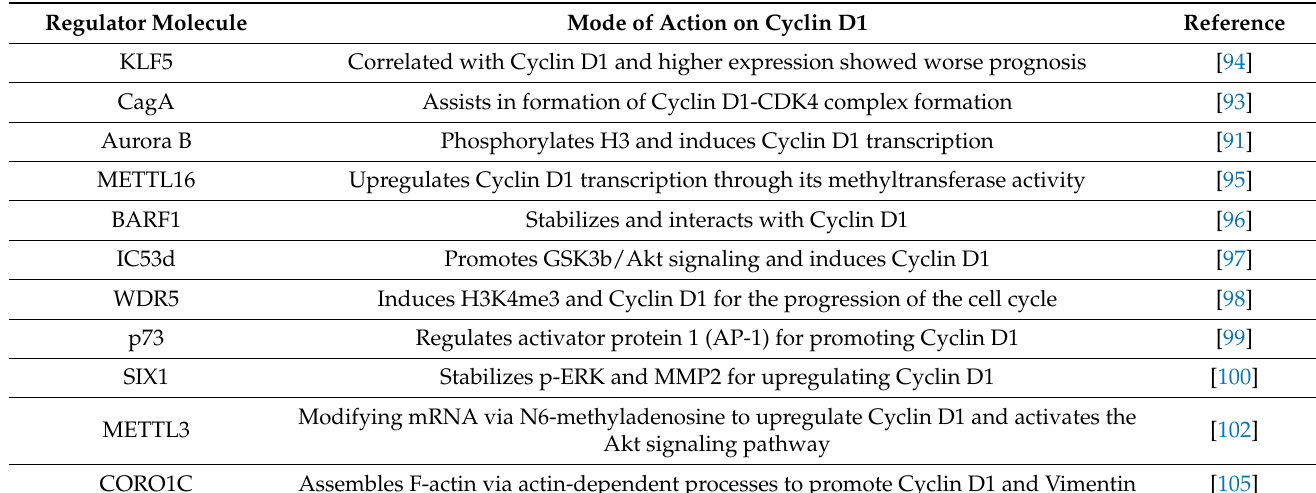
Table 2. The upstream molecules upregulating or activating Cyclin D1 in gastric cancer are shown, along with their mode of action.